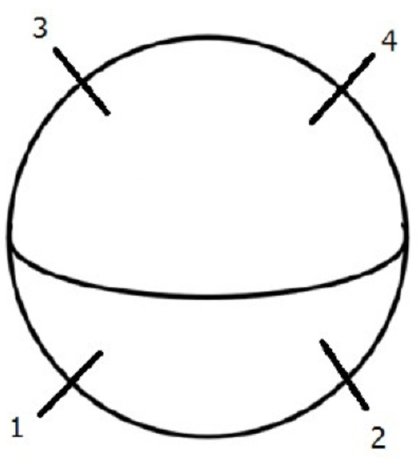
Figure 16 . Illustration of four ground state scattering 1 + 2 ! 3 + 4 where the surface is an S 2